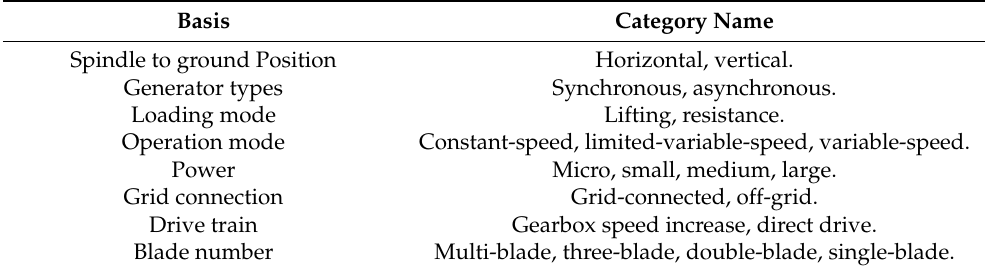
Table 1. Common types of wind turbines [19,20].